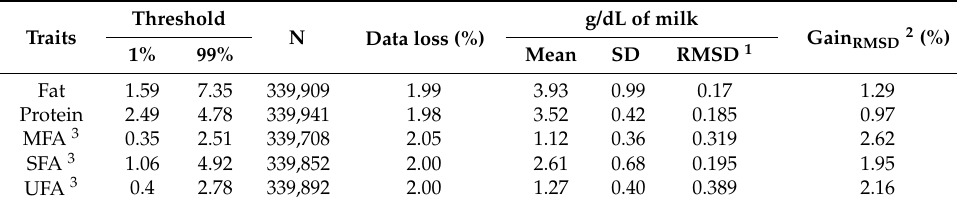
Table 3. Characteristics of the dataset obtained after a cleaning using the externally predicted values observed at the 1% and 99% quartiles as thresholds (Method 1).